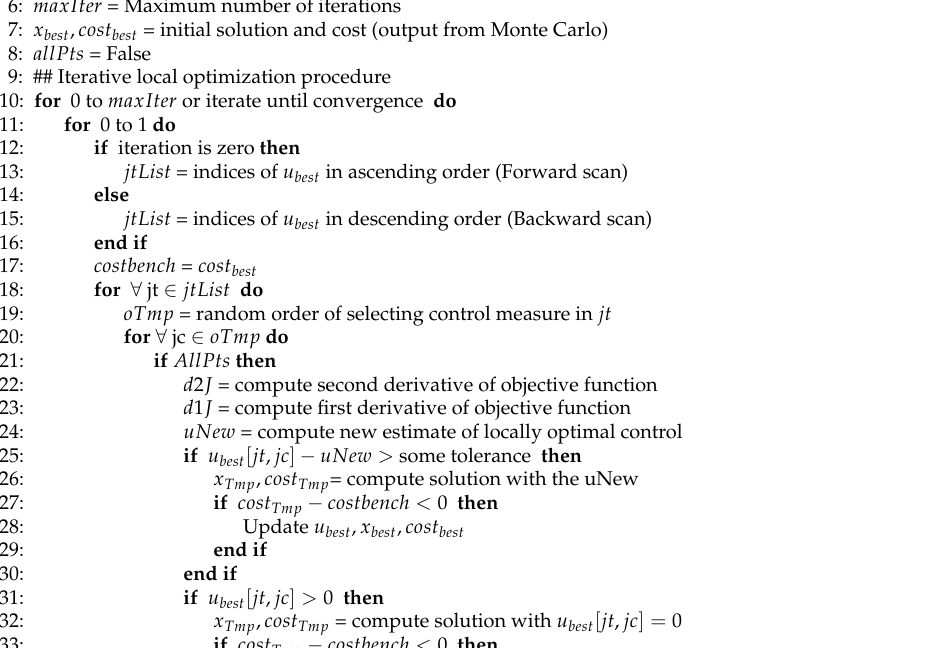
Algorithm 2: Pseudocode for local